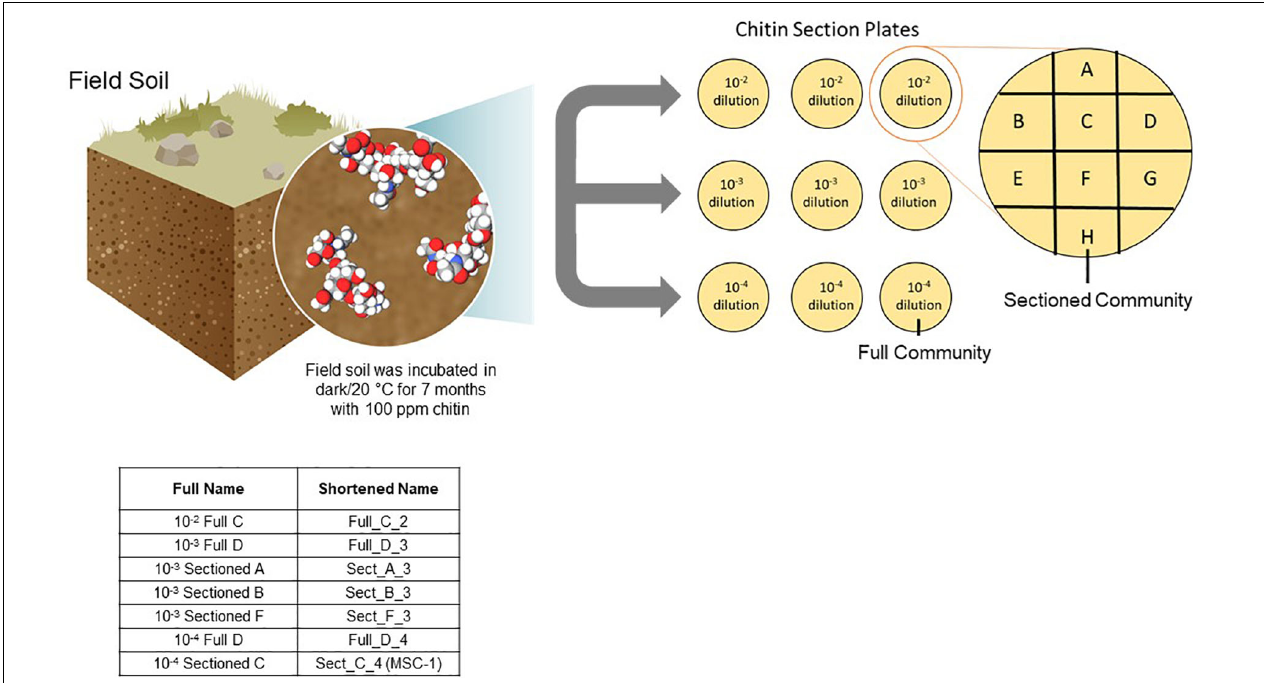
FIGURE 1 | Approach to generating reduced complexity communities. Soil was isolated from an arid grassland field site and incubated with 100 ppm chitin for seven months. Samples of this chitin enriched soil microbiome were collected and diluted to 10 − 2 , 10 − 3 , and 10 − 4 and plated onto agar plates containing 100 ppm chitin. After one week of growth resulting microbial biomass was either collected from the entire plate and replated onto a new plate (representing a Full community) or sections of the plate were collected separately and replated onto a new plate (representing a Sectioned community). Microbial growth was then replated weekly and amplicon sequenced. Inset table shows the naming of several consortia tested for storage and reproducibility as well as one consortium tested further